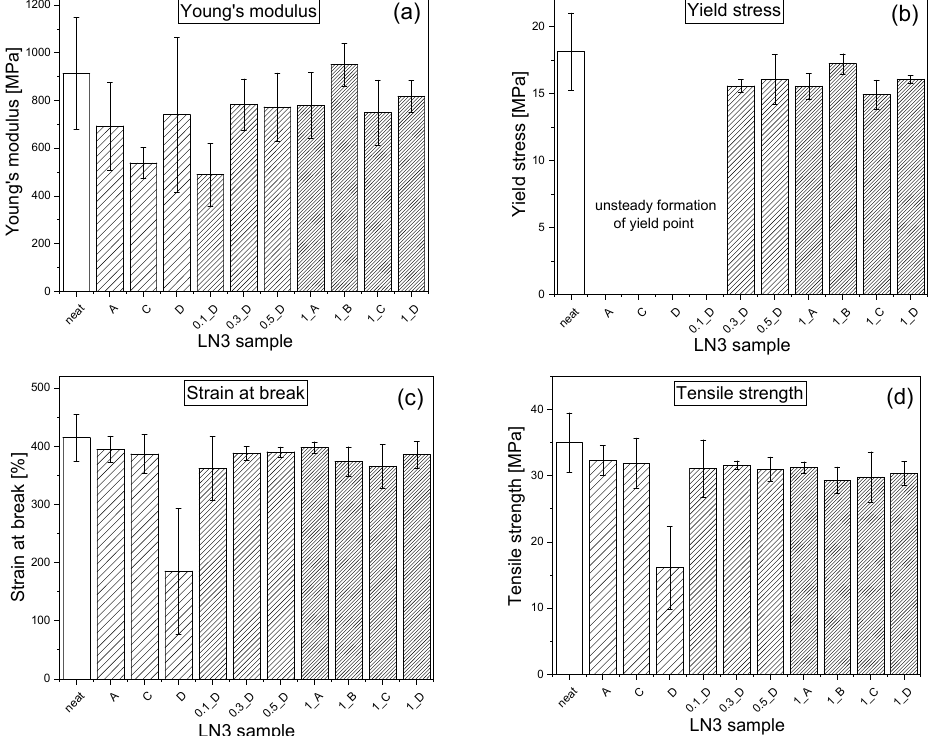
Figure 11. Mechanical characteristics of LN3 and LN3 / MWCNT composites evaluated from tensile tests: ( a ) Young’s modulus, ( b ) Yield stress, ( c ) strain at break, and ( d ) tensile